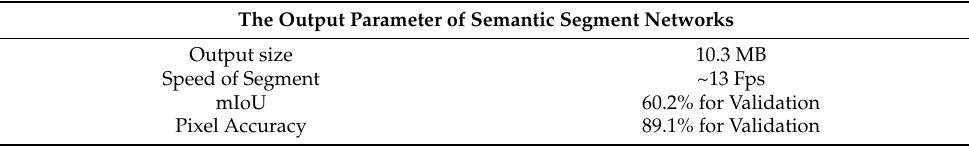
Table 3. The performance of the proposed semantic segment networks.